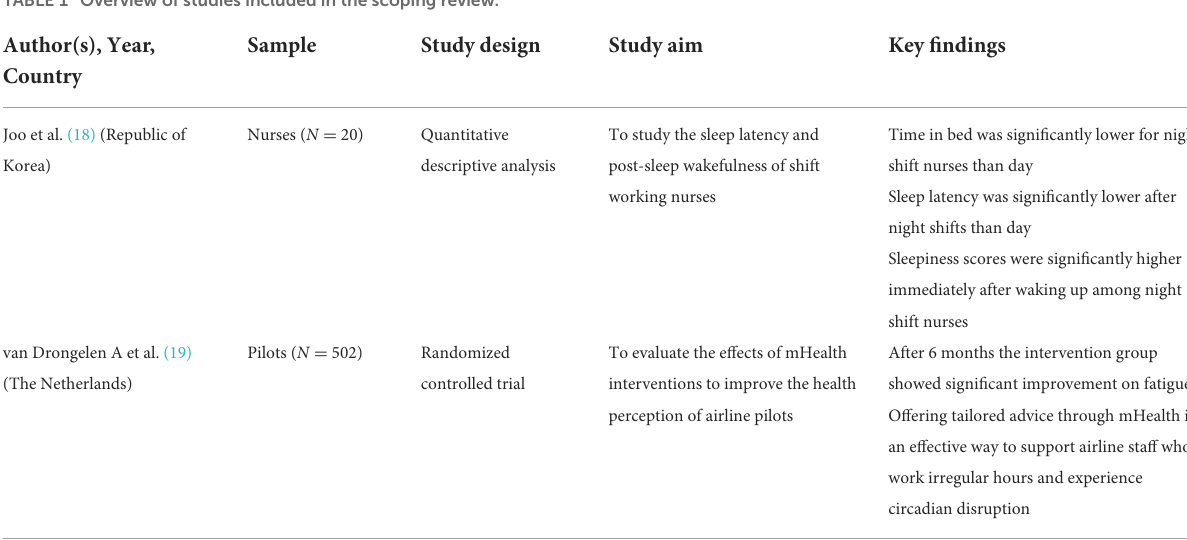
TABLE 1 Overview of studies included in the scoping